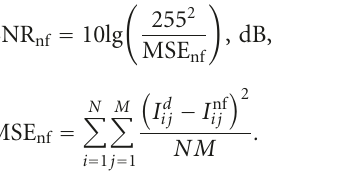
) for the test image Barbara. n